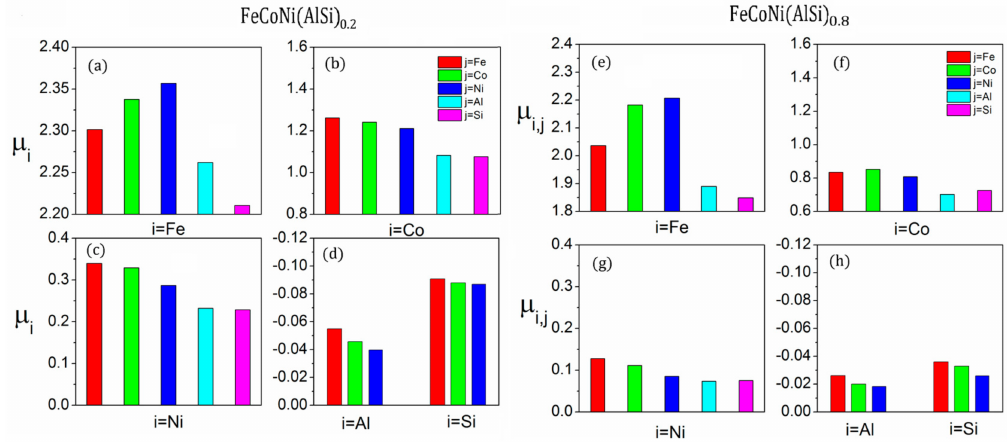
Figure 5. The average magnetic moments µ i , j (unit in µ B ) with different nearest neighbor elements: ( a – d ) for FeCoNi (AlSi) 0.2 alloy; ( e – h ) for FeCoNi (AlSi) 0.8 alloy. The FeCoNi(AlSi) 0.8 phase contains more Al and Si components. The SRO parameters of Ni-Al, Co-Si, Co-Al, Fe-Si and Ni-Si pairs are more negative. It is obvious that the Fe, Co and Ni atoms prefer to gather around the Si atom, while the Ni and Co atoms prefer to gather around the Al atom. The SRO greatly alters the local environment of the magnetic atoms, which will further reduce the average magnetic moments of the magnetic atoms. The average magnetic moment of the Fe atoms changes from 2.10 to 2.03 µ B , Co atoms from 0.94 to 0.76 µ B . Due to the enrichment of Al and Si atoms in the nearest neighboring shell of Ni atoms, the magnetic moment of Ni atoms vanishes. The saturation magnetization changes from 0.67 T with the random structure to 0.6 T with the SRO structure. The saturation magnetization with SRO is closer to the experimental value = 0.46 T